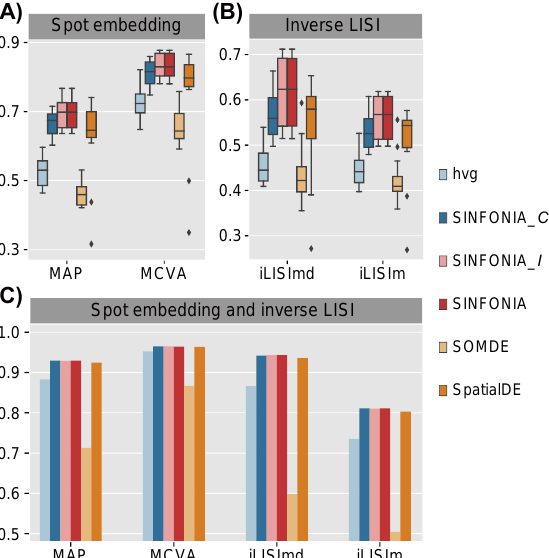
Figure 4. ( A ) Performance of MAP and MCVA on the 12 DLPFC datasets. ( B ) Performance of iLISImd and iLISIm on the 12 DLPFC datasets. ( C ) Performance of MAP, MCVA, iLISImd and iLISIm on the MBC dataset.